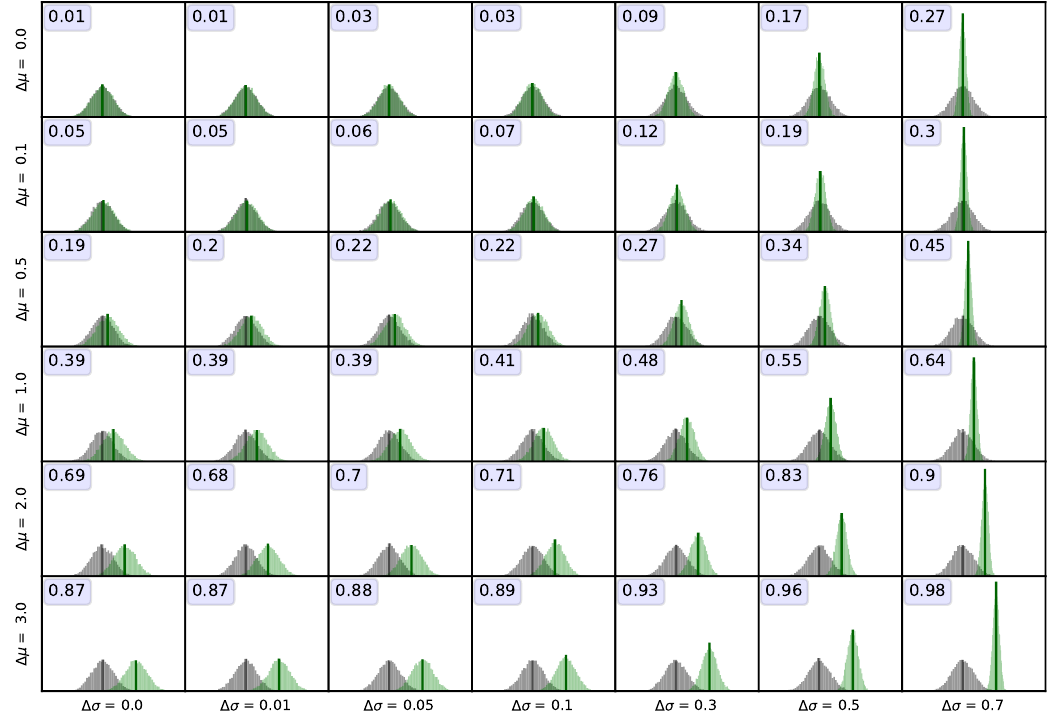
Figure 2.1: The value of the KS statistic, Eq. (2.13), between two Gaussian distributions = 10 4 times each. The grey distribution has mean µ sampled N rep = 1. The green distribution has mean µ tion σ 0